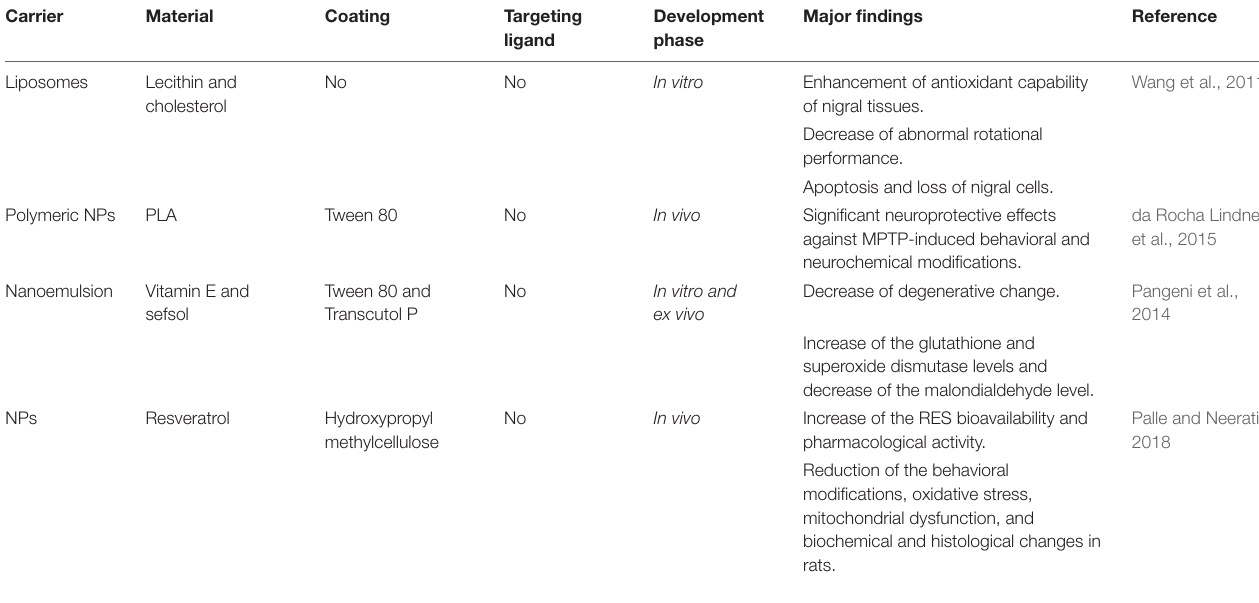
TABLE 2 | Currently developed DDS for RES delivery for PD’s